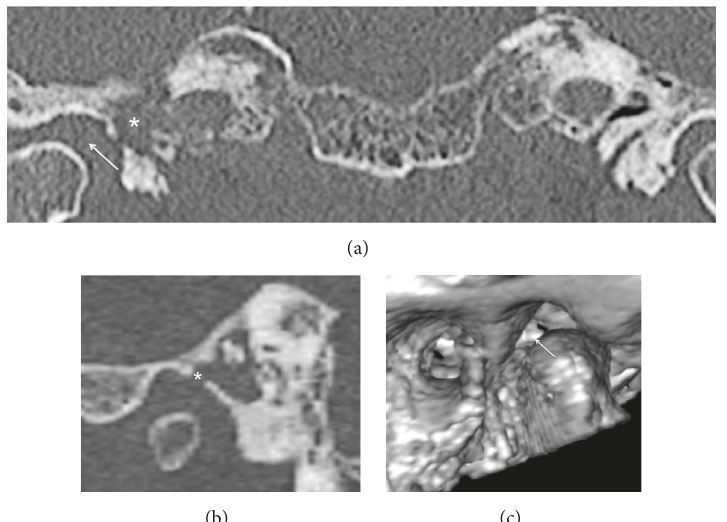
Figure 7: (a) The asterisk shows erosion of the temporal bone around the carotid canal (peritubal mastoiditis). The arrow shows a widened TMJ cavity. (b) Defect in the anterior tympanic cavity wall (asterisk). (c) A 3D volume rendering technique shows the same defect from the fossa mandibularis perspective